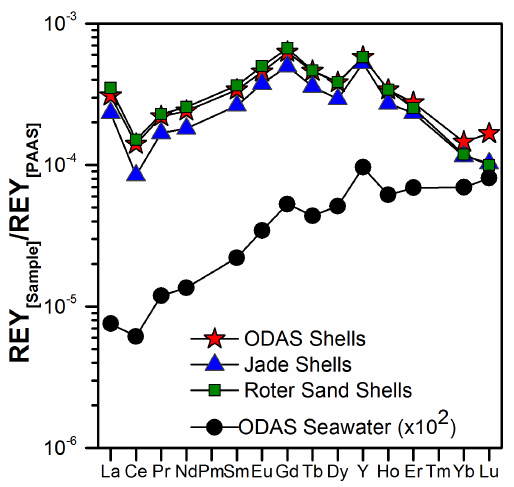
Figure 4. REY SN patterns of Mytilus edulis shells from different sites in the North Sea compared to seawater from the ODAS site. Note the close similarity between all REY SN patterns regardless of their origin.